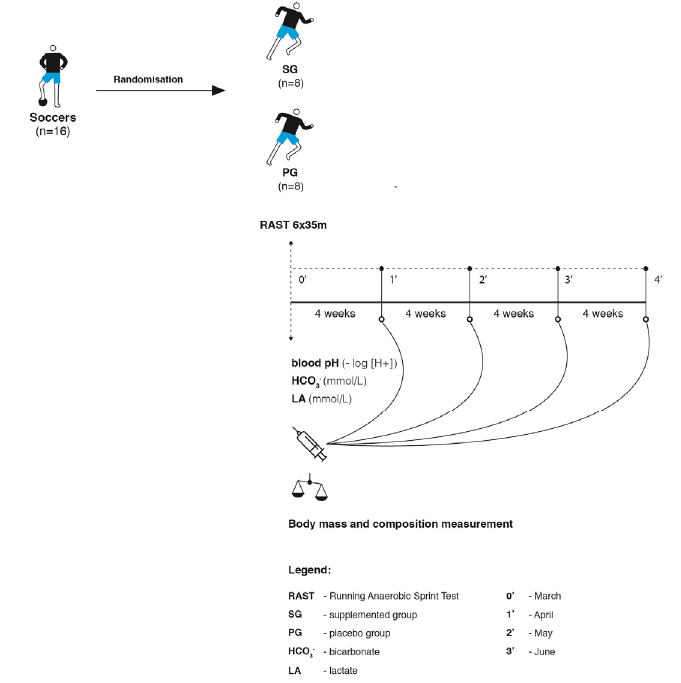
Figure 1. Scheme of testing procedures.